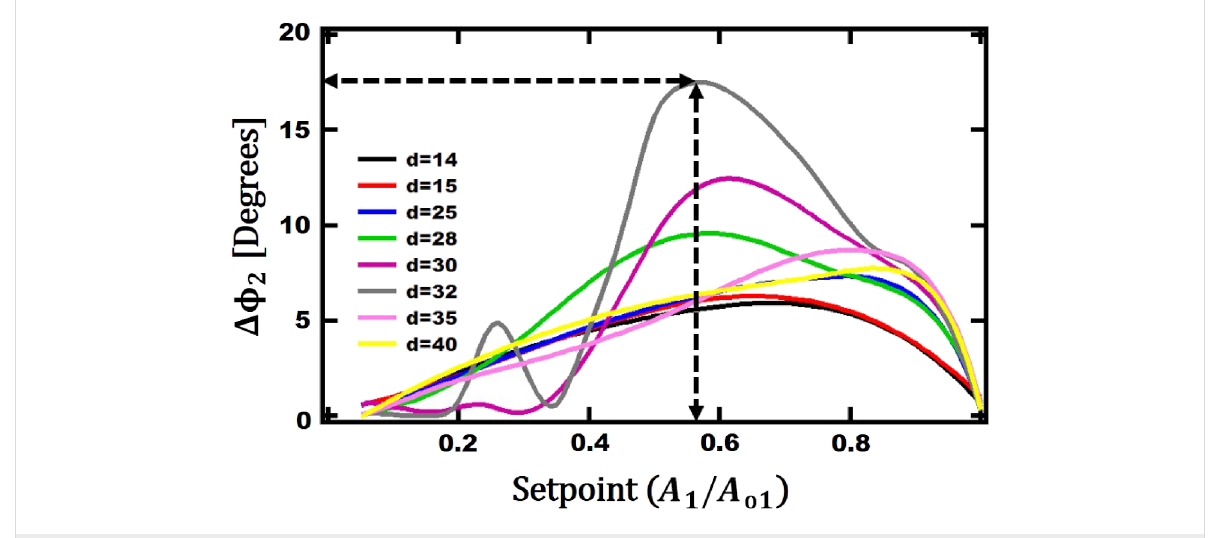
Figure 8: Phase difference of the Second eigenmode between Au and PS as a function of the setpoint for a given cantilever leg width length. The other geometrical parameters are: L opt = 90 µm, b opt = 254 µm, and t ref = 0.4 µm.